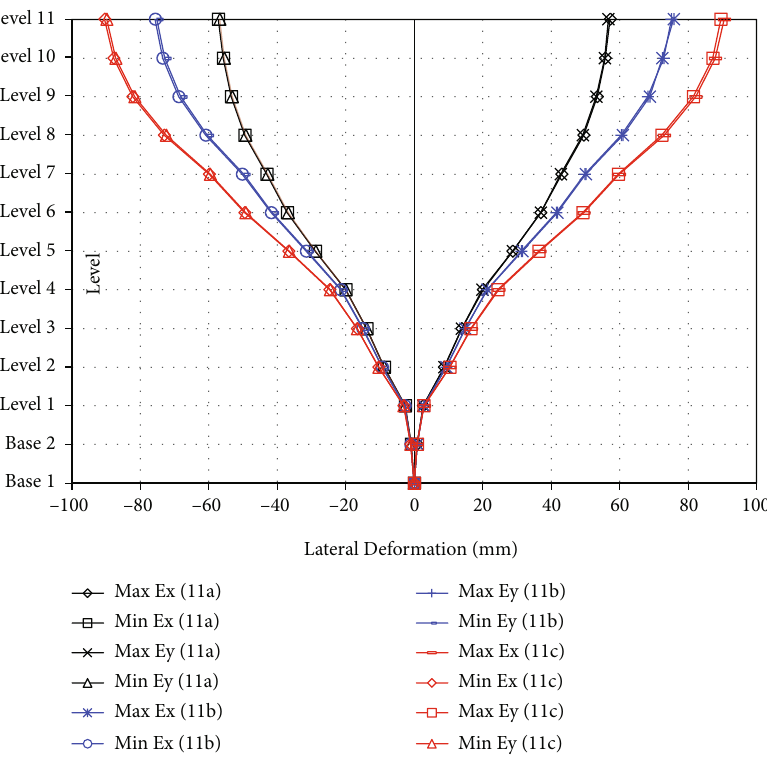
Figure 7: Lateral deformation due to the E Table 2: Base shear of Meru model due to the E